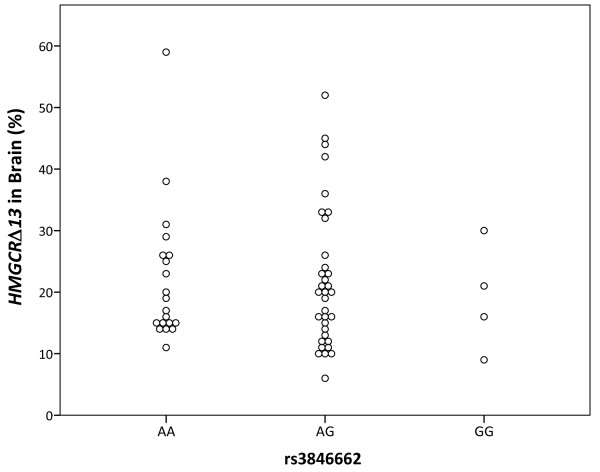
Rs3846662 is not associated with percent HMGCRΔ13 in human brain. However, we are underpowered to observe a significant difference (p ≤ 0.05) in percent HMGCRΔ13 between rs3846662 genotypes given the overall high level of exon 13 inclusion in brain cDNA and the possibility that rs3846662 may affect HMGCR exon 13 in a cell-type dependent manner.